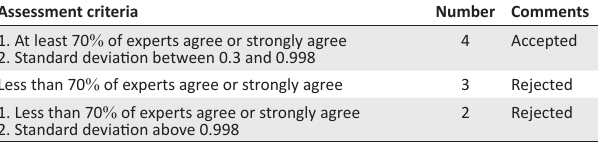
TABLE 4: Screening process for indicators during pre-assessment. Assessment criteria